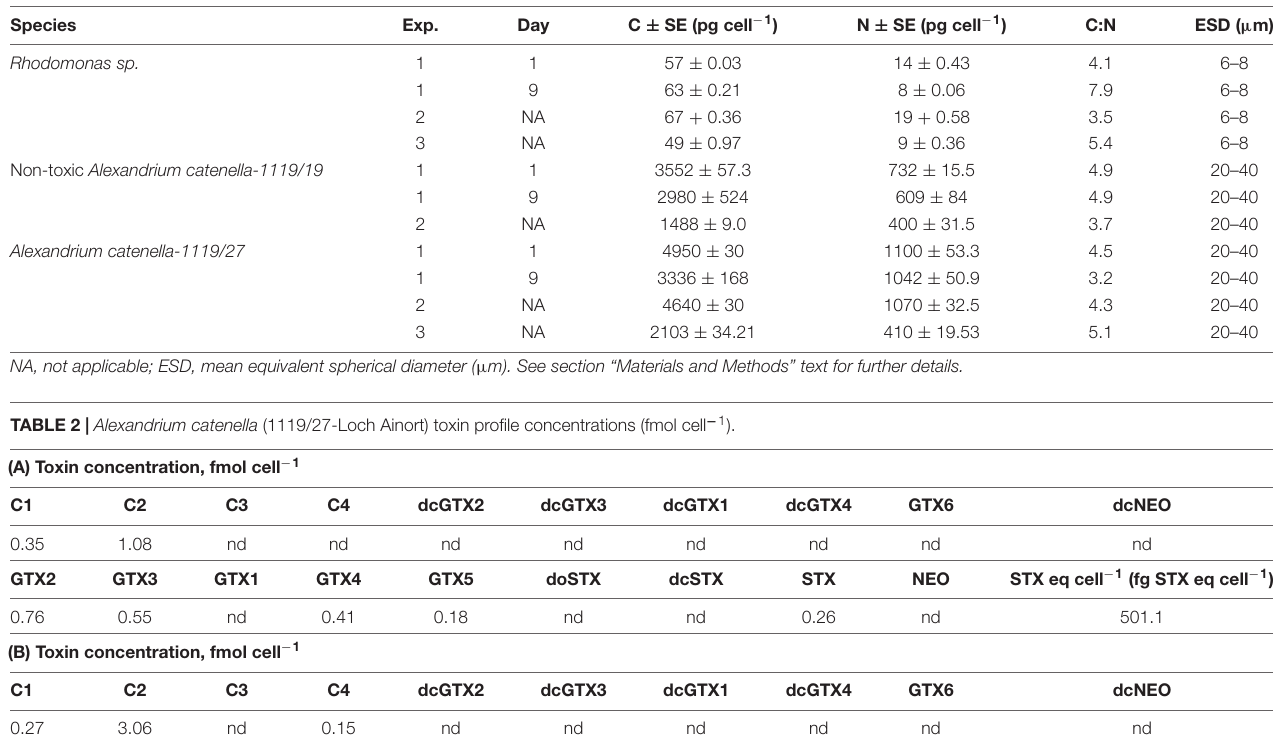
TABLE 1 | The concentrations of carbon (C) and nitrogen (N) (pg cell − 1 ) ± standard error (SE) in the different prey cells offered to Acartia tonsa in the three experiments (Exp.). Species Exp. Day C ± SE (pg cell − 1 ) N ± SE (pg cell − 1 ) C:N ESD ( µ m) Rhodomonas sp.